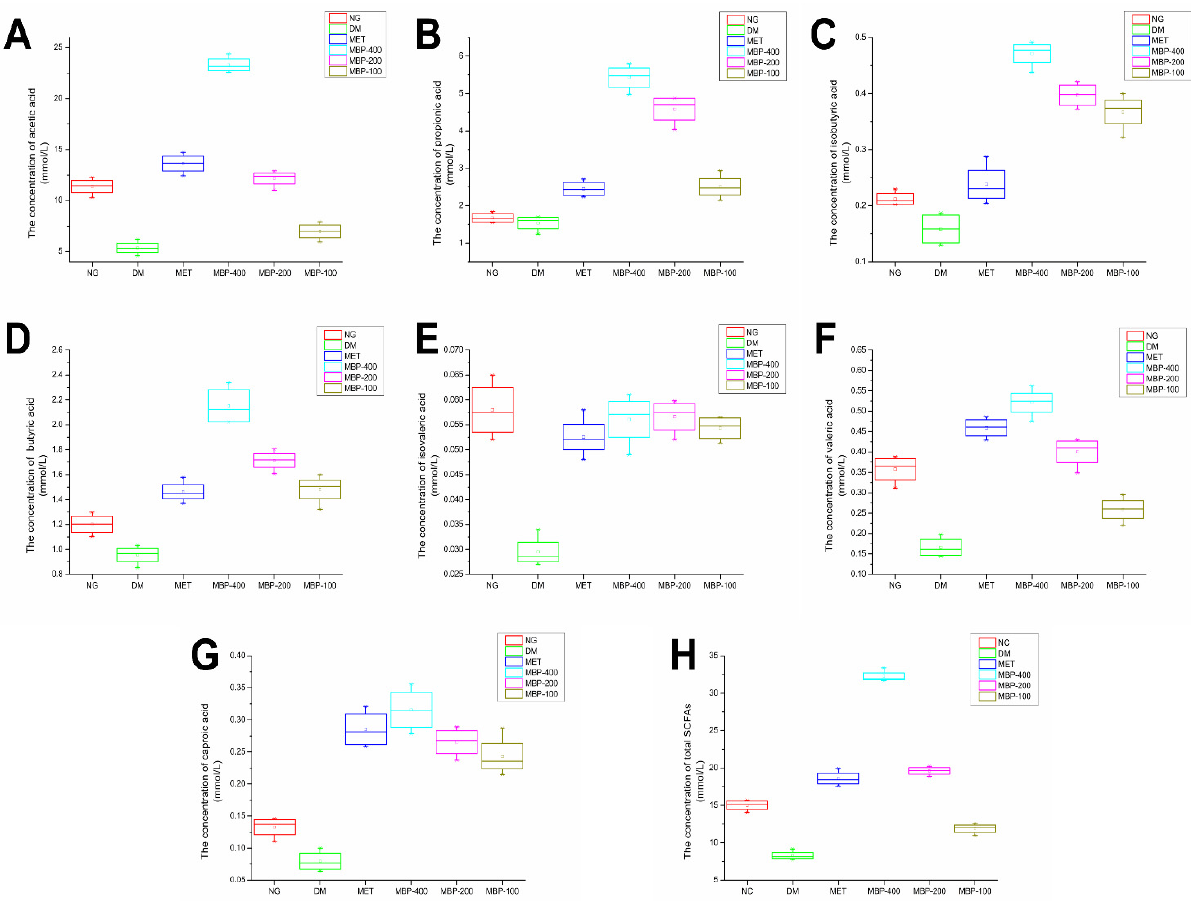
Figure 6. Levels of SCFAs in six groups, AA ( A ), PA ( B ), iBA ( C ), BA ( D ), iVA ( E ), VA ( F ), CA ( G ) and total SCFAs ( H ).